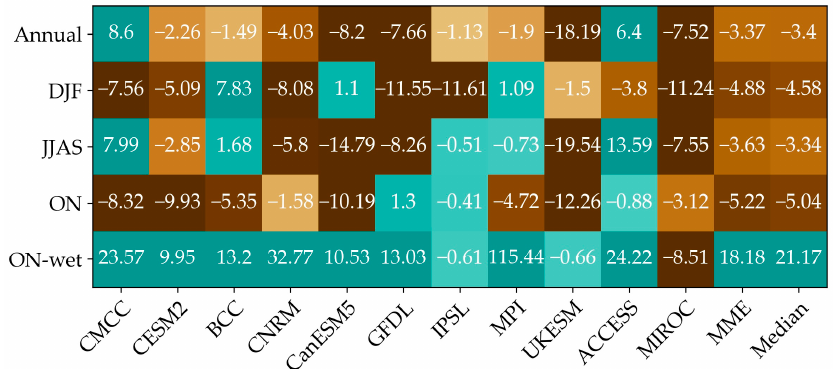
Figure 9. Same as Figure 7 but for changes in PR. The brown shades illustrate drying and the green shades show we tt ing. Figure 10. Changes in PR (%) based on averages over the robust grid cell at mm/year for the respec- tive seasons and models. The shades of green indicate wet means (di ff erences above zero) and the shades of brown denote dry means (di ff erences below zero). The darker the shade the bigger the di ff erence.